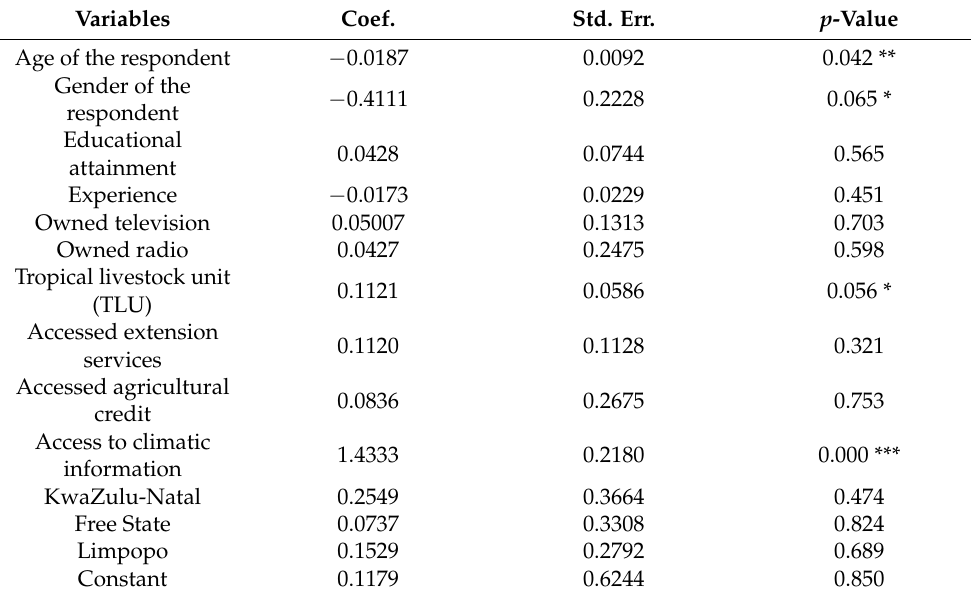
Table 2. Factors influencing the adoption of CCAS. Variables